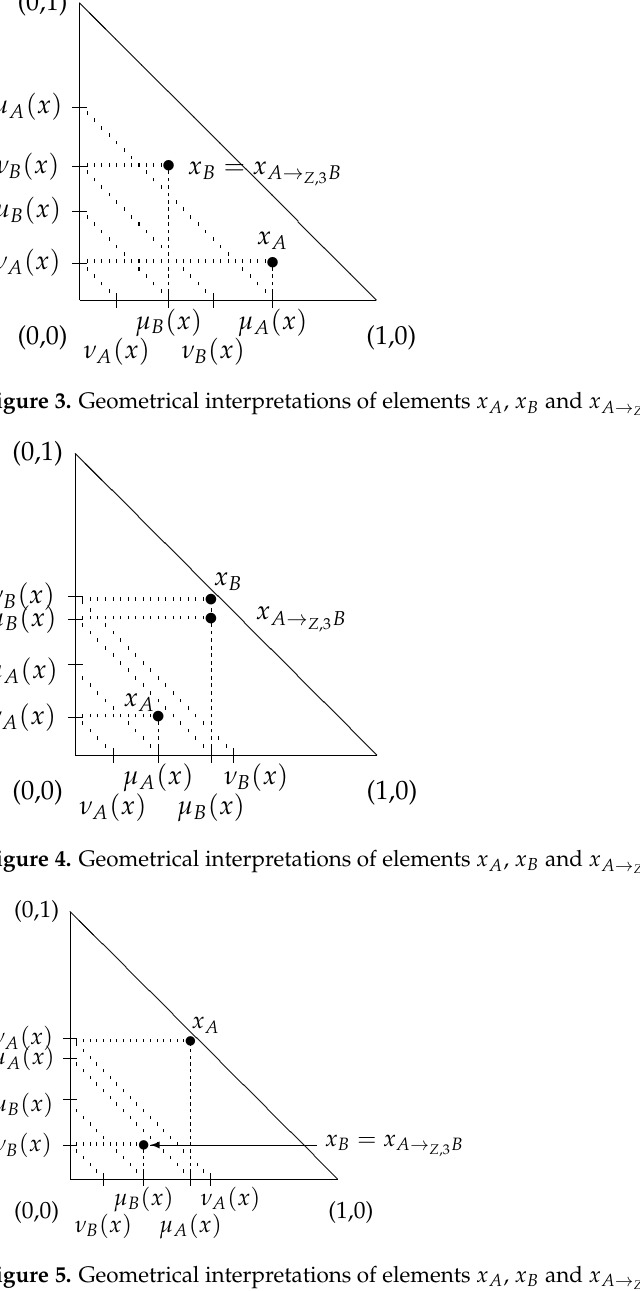
B —the fourth → Z ,3